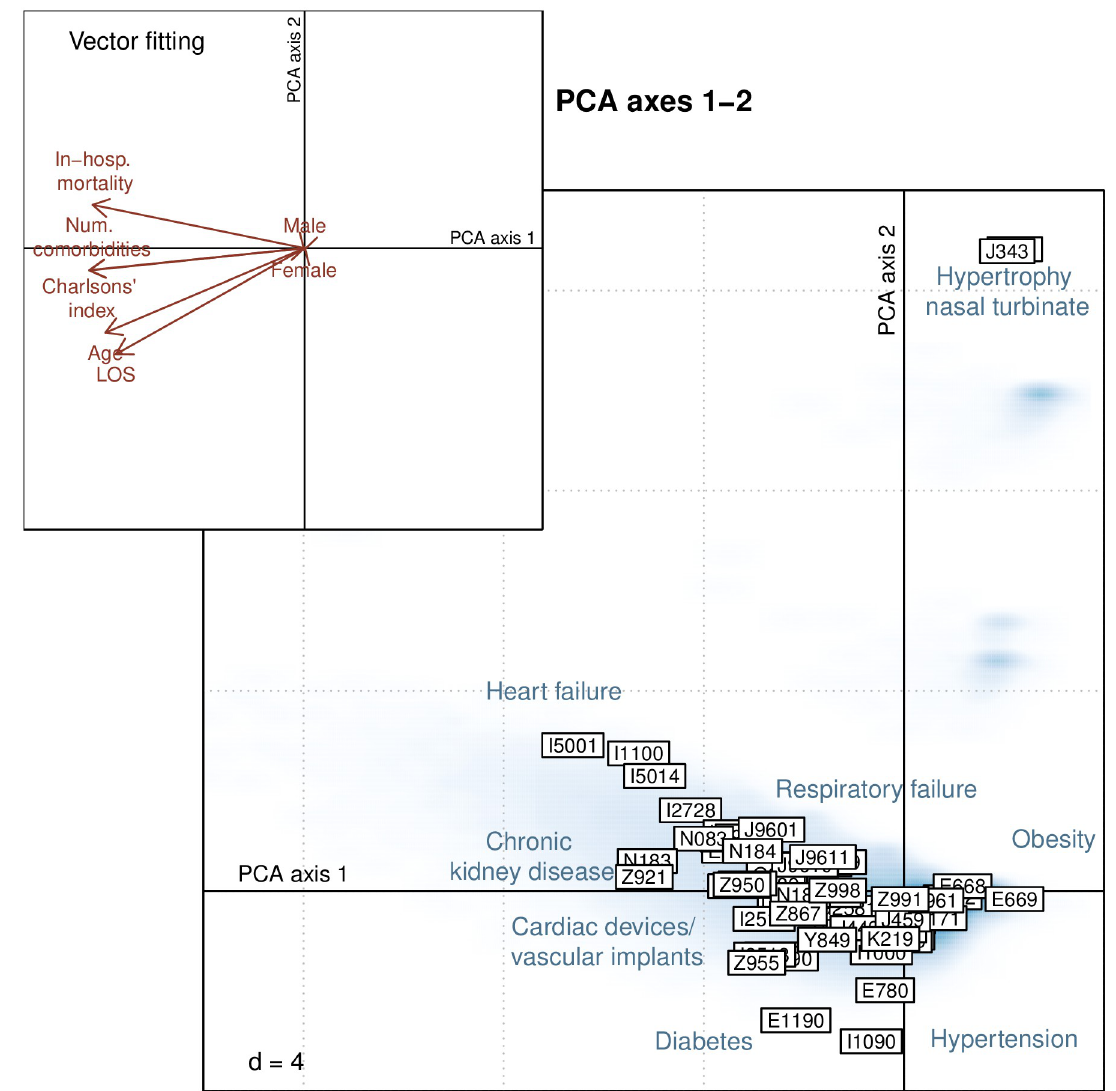
Fig 3. Principal component analysis (PCA) biplot of comorbidities associated with sleep apnea. SA hospitalization cases are reported in smoothed blue density areas, whereas comorbidities (ICD-10-GM codes) are depicted by framed labels. Comorbidities lying in the same direction are correlated. Comorbidities lying far away from the center of the plot are the most influential comorbidities. As a help for interpretation, the upper left inset represents external explanatory variables fitted to the PCA plot. The association between comorbidities and explanatory variables is given by the direction of the